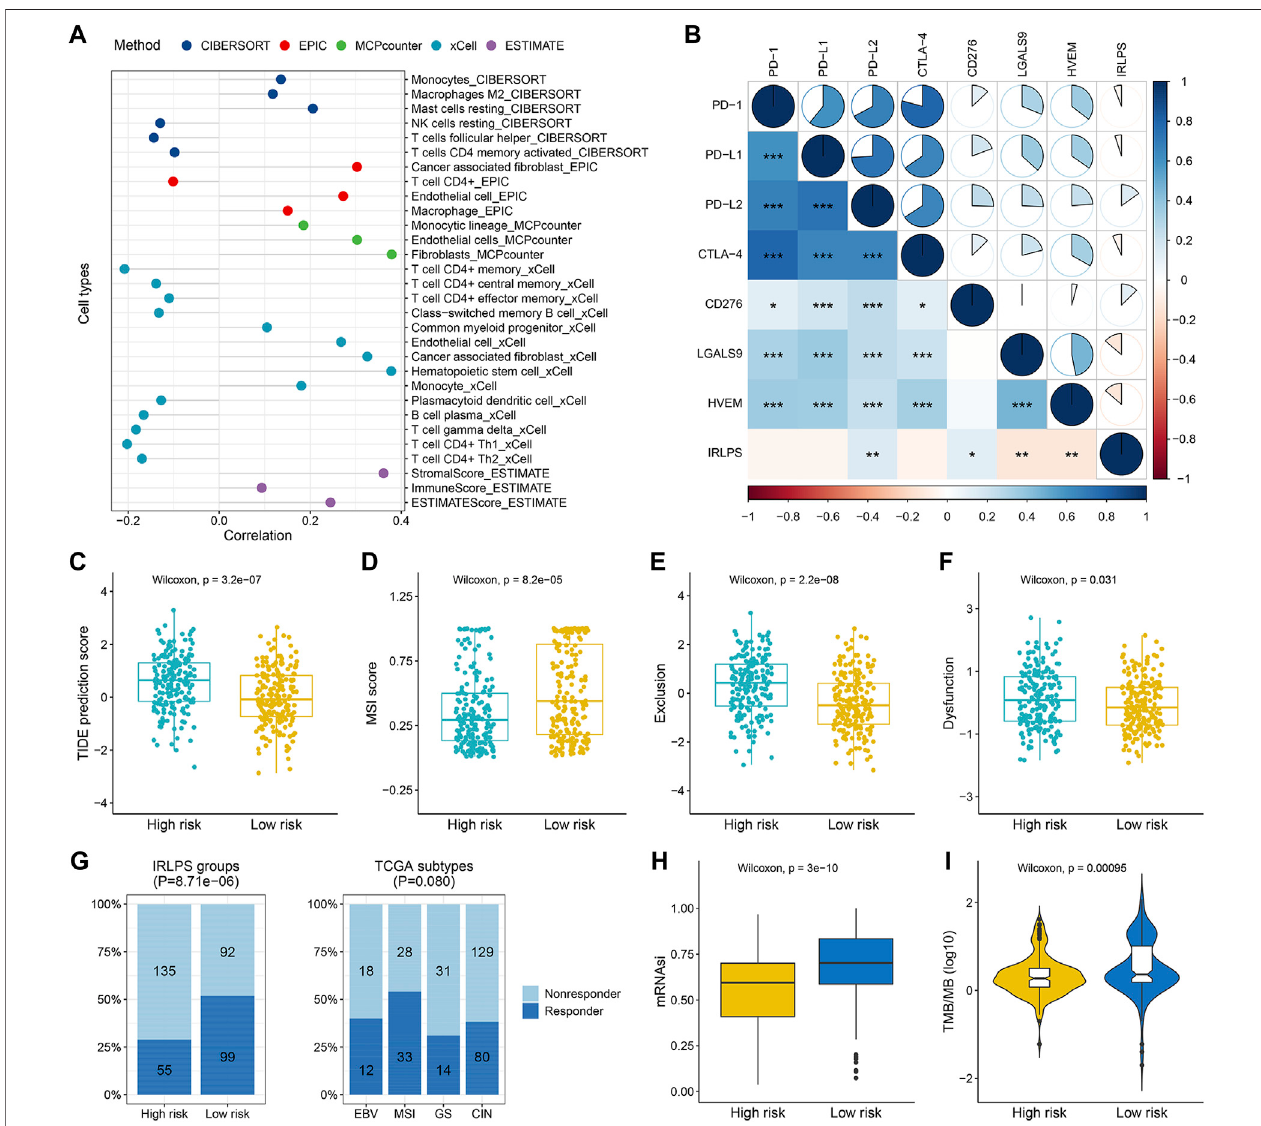
FIGURE 5 | The correlations between the tumor-in fi ltrating immune cells, immunosuppressed molecules, predicted immunotherapeutic responses, and our prognostic signature in the TCGA cohort. (A) Lollipop plot displayed the correlations between the signature and tumor-in fi ltrating immune cells estimated by different algorithms; (B) Correlogram showed the correlations between the signature and several crucial immune checkpoint genes, including PD-1 , PD-L1 , PD-L2 , CTLA-4 , CD276 , LGALS9 , and HVEM (correlation coef fi cients is represented by the area and colored according to the value; * p < 0.05, ** p < 0.01, *** p < 0.001); (C – F) Comparisons of the Tumor Immune Dysfunction and Exclusion (TIDE) scores, T cell exclusion scores, dysfunction scores, and microsatellite instability (MSI) scores betweenthehigh-andlow-riskgroups; (G) Comparisonsoftheproportionsofpredictedrespondersandnon-responderstoimmunotherapyamongdifferentriskgroups (left panel) and TCGA subtypes (right panel); (H) Boxplot demonstrated the higher stemness index (mRNAsi) in the low-risk group; (I) Violin plot showed the signi fi cant difference in the tumor mutation burden (TMB) between the high- and low-risk groups.